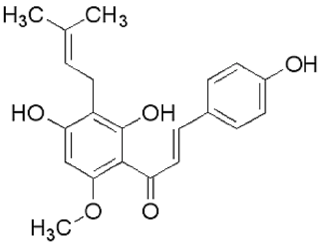
Figure 2. Chemical structure of xanthohumol.